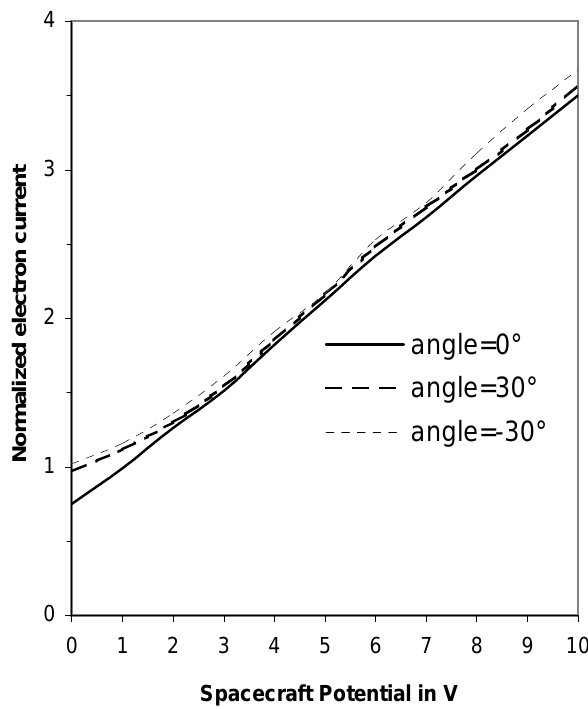
Fig. 5. Normalized electron current-voltage characteristics for T e = 1eV, B 0 = 1 µ T and different values of the angle α between B 0 and the x − y plane: α = − 30 ◦ (thin dashed curve), α = 0 ◦ (solid curve) and α = 30 ◦ (thick dashed curve).